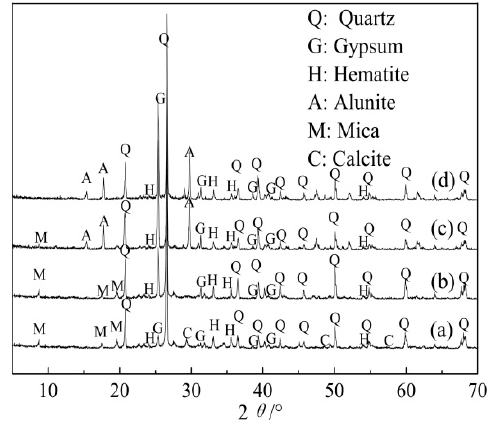
Figure 7. The XRD patterns for roasted stone coal ( a ); dephosphorization sample ( b ); leaching residue (I) ( c ); and leaching residue (II) ( d ). Table 3. Content of V, Fe, Al and P for each stage filtrate (mg/L).